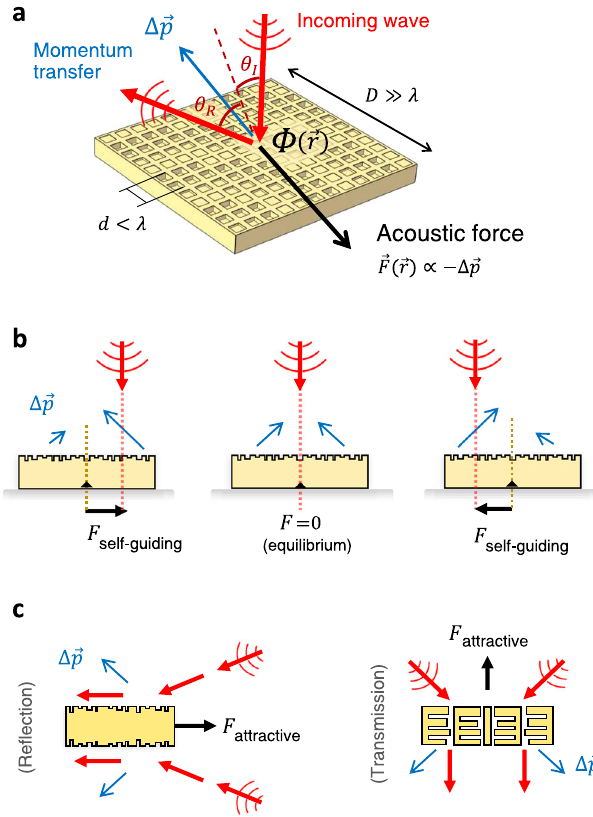
Fig.1|Shapingcontactlessforceswithmetasurfacesthatsteeracousticwaves. a The local force F ð r Þ is proportionalto the momentumchange Δ p (blue),which is controlledbythelocalphase Φ ð r Þ .Throughthespatialdesignofthesubwavelength ( d < λ ) unit cells of the metasurface, complex force pro fi les can be generated to enablenewmechanismsforcontactlessactuation. b Self-guidingmetasurfacescan autonomouslyself-locktoandfollowtheremotewavesource.Theirabilitytomove asthesourcemovesstemsfromthescatteringasymmetrywhichpinsthecenterof the metasurface to the source radiation axis (dashed red). E.g., when the meta- surfaceisalignedontheaxis,nonetforceispresent(middle);butifthesourcehas movedthemetasurfacewillfollow(left,right). c Pullingforce:metasurfacescanbe not just pushed from, but also pulled towards the radiation source (here shown as two independent non-interacting incident